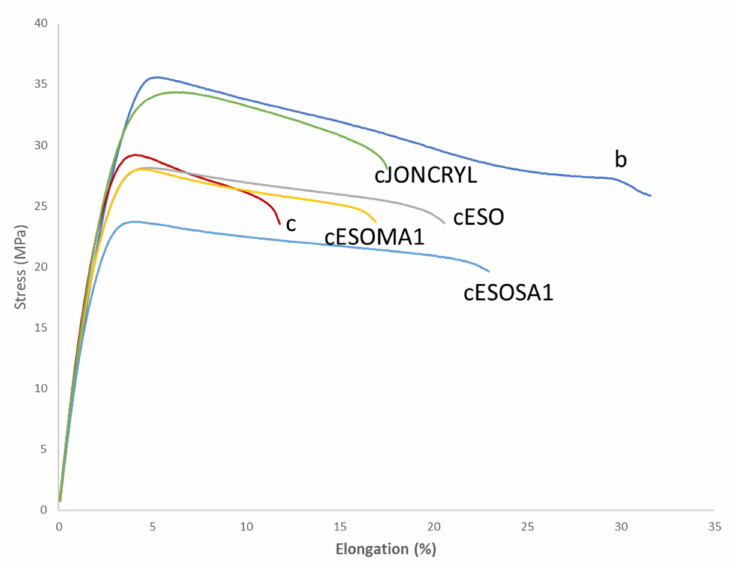
Figure 9. Representative stress–strain trends of selected formulations. b is the PLA/PBSA 60/40 blend; c is the composite with 20% bran; cESO is the composite plasticized with ESO; cE- SOMA1 is the composite with ESO + MA; cESOSA1 is the composite with ESO + SA; cJONCRYL is the composite with